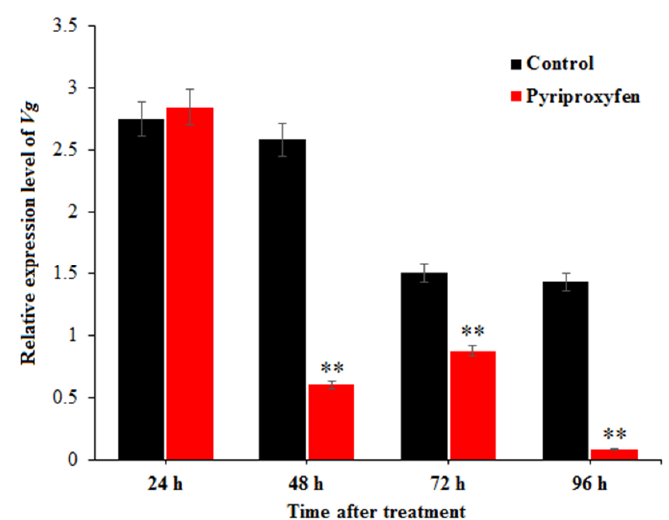
Figure 3. Expression-level changes of Vg in the ovary of silkworm at different times after pyriproxyfen